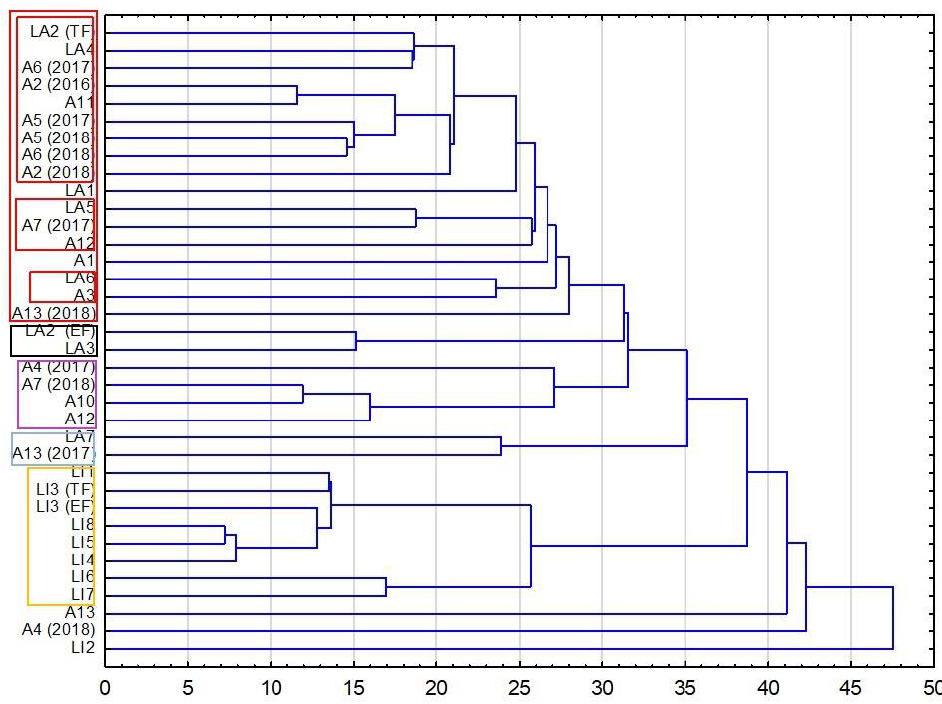
Figure 6. Dendrogram obtained via the HCA analysis of all obtained data based on the average content of EO components in different cultivars.